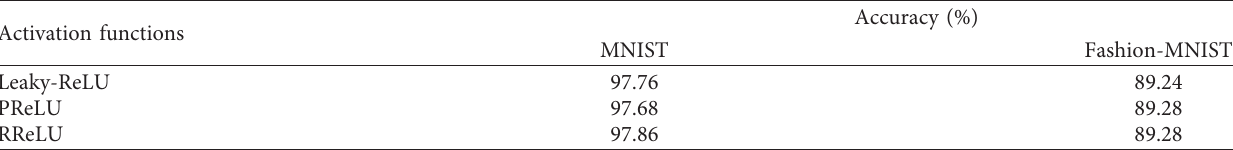
Table 11: Classification accuracy rates of N-D 2 NN with different activation